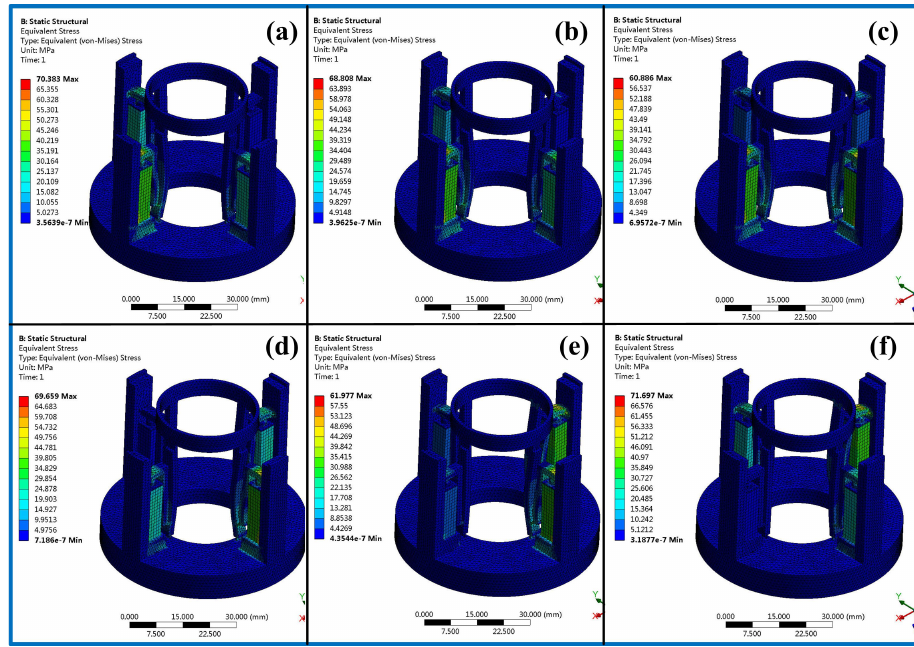
Figure 20. Stress analysis results at different times. ( a ) At t = 0 s; ( b ) at t = 0.01 s; ( c ) at t = 0.025 s; ( d ) at t = 0.05 s; ( e ) at t = 0.075 s; ( f ) at t = 0.1 s.